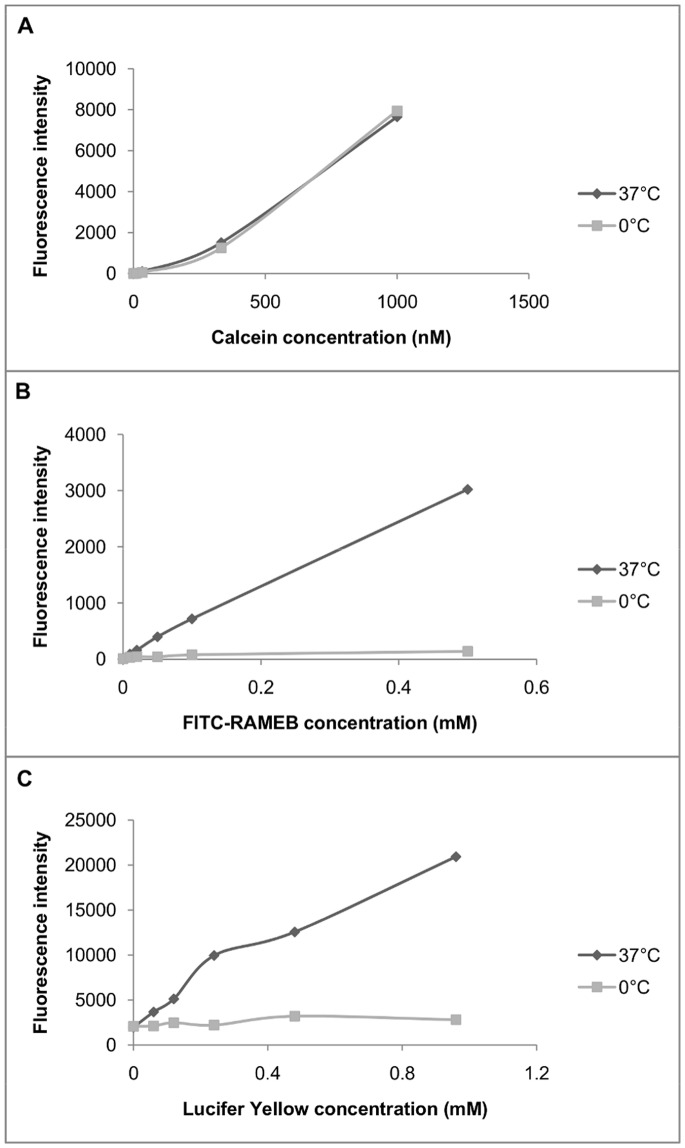
Cellular uptake of calcein-AM (A), FITC-RAMEB (B) and Lucifer Yellow (C) as a function of ligand concentration.Cells were treated at 37°C and 0°C and the cellular fluorescence was determined by flow cytometry, after excluding dead cells with propidium iodide.(Graphs show results of a representative experiment).